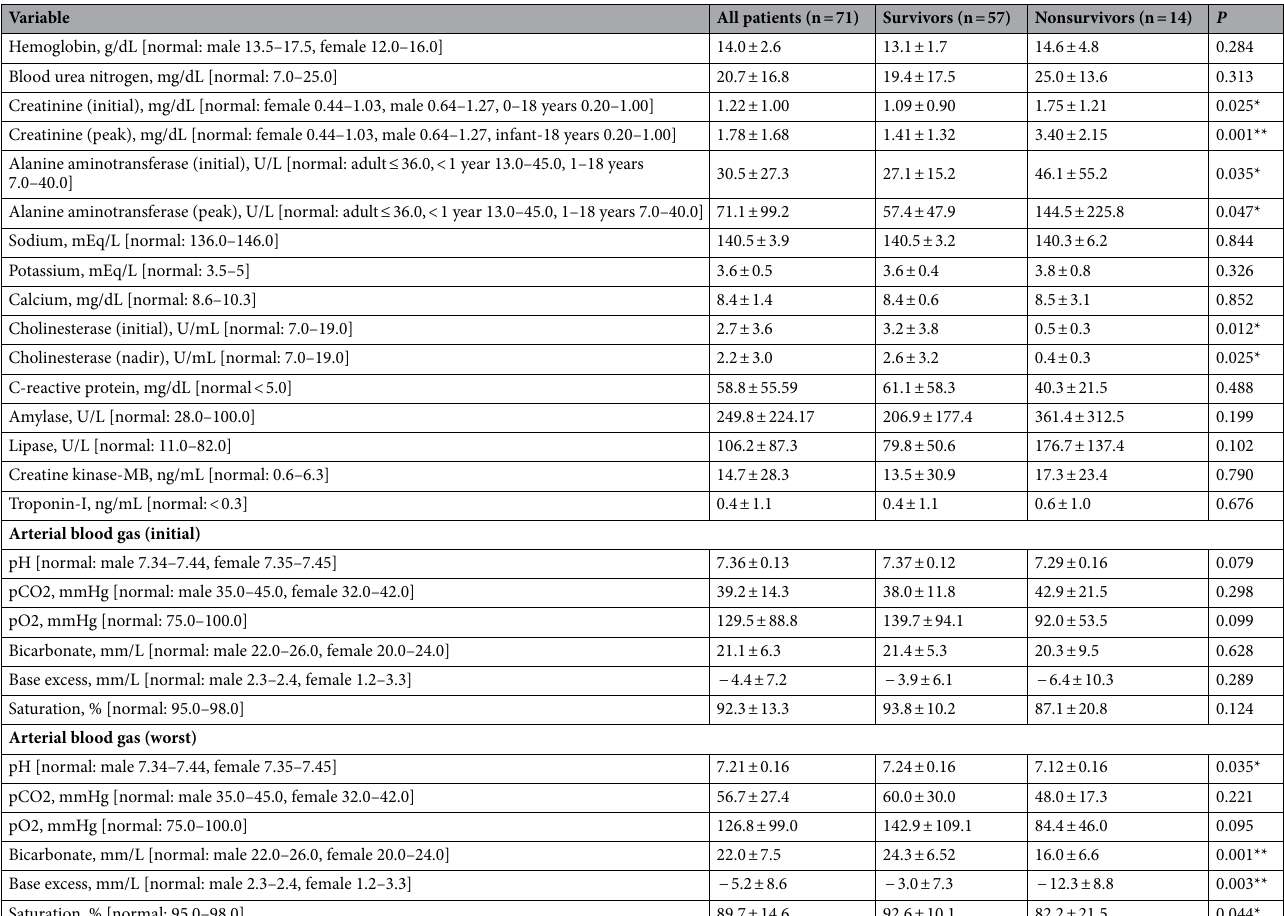
(Fig. 1, log-rank test, chi-square = 42.704, P < 0.001). Discussion Literature on the mortality data of elderly patients with organophosphate intoxication has been limited. The overall mortality rate was 19.7% in this study. Acute cholinergic crisis, intermediate syndrome, and delayed neuropathy developed in 100.0%, 15.5%, and 4.2% of patients, respectively. A substantial proportion of the elderly organophosphate patients (52.1%) suffered respiratory failure neces- sitating mechanical ventilatory support. In a review article, Giyanwani et al. 24 found that 491 of 1996 (24.6%) patients suffered acute respiratory failure after organophosphate intoxication. One of the overwhelming choliner- gic features of organophosphate intoxication is respiratory failure. The mechanisms of respiratory failure follow- ing organophosphate intoxication involve three components: respiratory center depression, respiratory muscle weakness, or cholinergic pulmonary effect (bronchospasm and bronchorrhea) 24 . Relatively impaired baseline functions of these systems in elderly adults may worsen respiratory depression during pesticide intoxication.